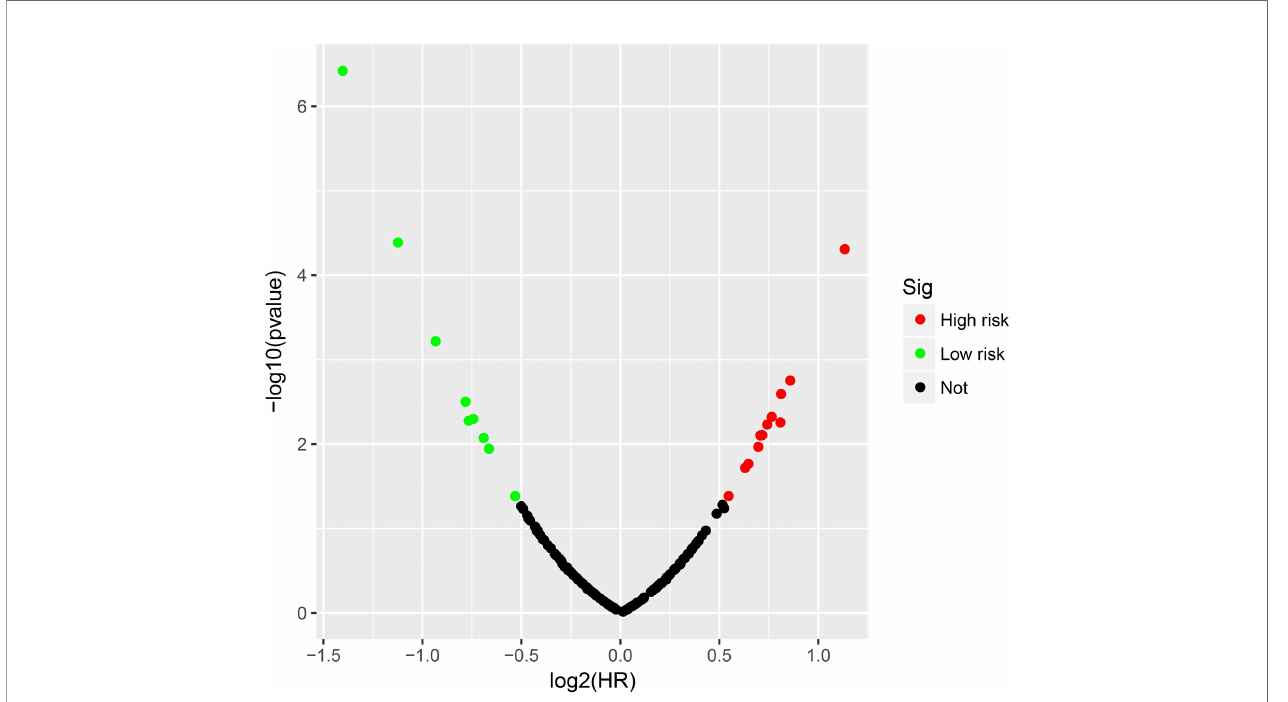
FIGURE 1 | Volcano plot of snoRNAs survival analysis results in TCGA LGG